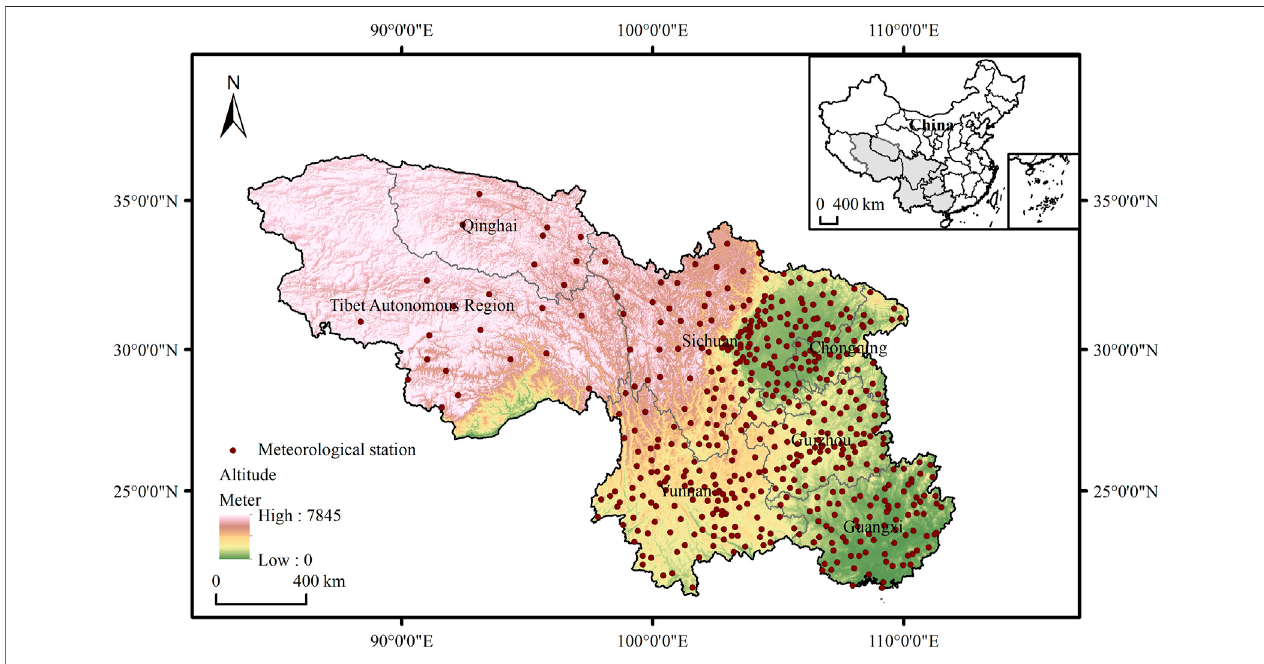
FIGURE 1 | Study area and 494 meteorological stations in Southwest